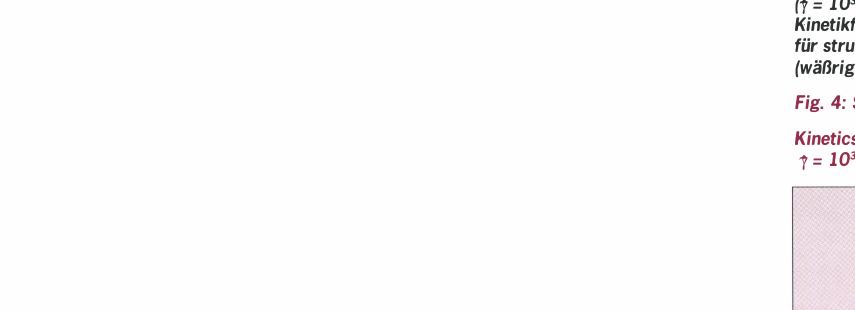
• ScherzeiVshear time 180 s/180 s 6. ScherzeiVshear time 720 s/720 s D ScherzeiVshear time 1080 s/1080 s 0.005